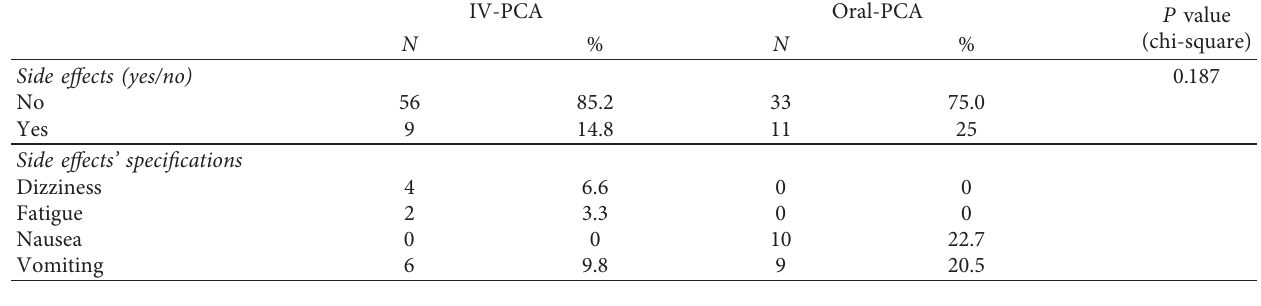
Table 4: Rate and specifications of side effects related to pain treatment in the general study population. Statistical analysis was performed by the chi-square method.